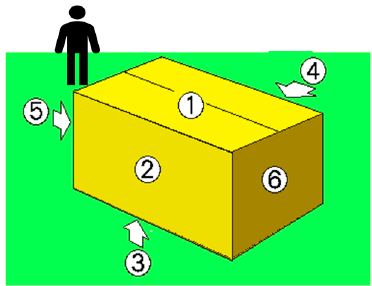
Figure 5. Drop-test placement if face direction are known [41].